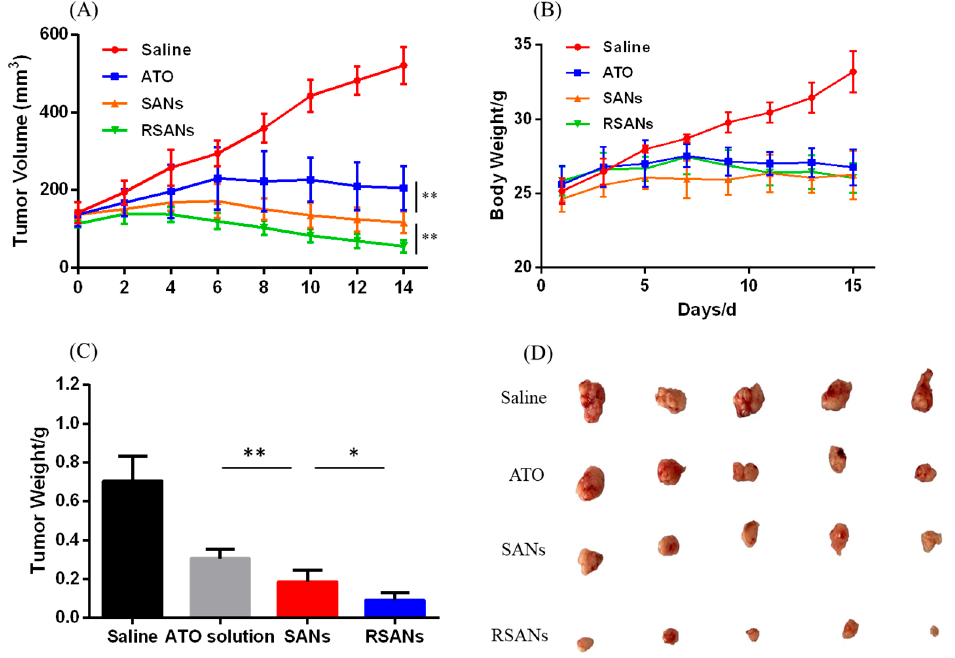
Figure 11. In vivo anti-tumor efficacy of formulation in the 7721 tumor bearing nude mice study. Changes of ( A ) tumor volume and ( B ) body weight during the period of treatment. ( C ) Average tumor weight after treatment. ( D ) Photograph of tumors collected after treatment. Data are shown as ± SD of the mean ( n = 5). ** correspond to p < 0.01, * correspond to p < 0.05.